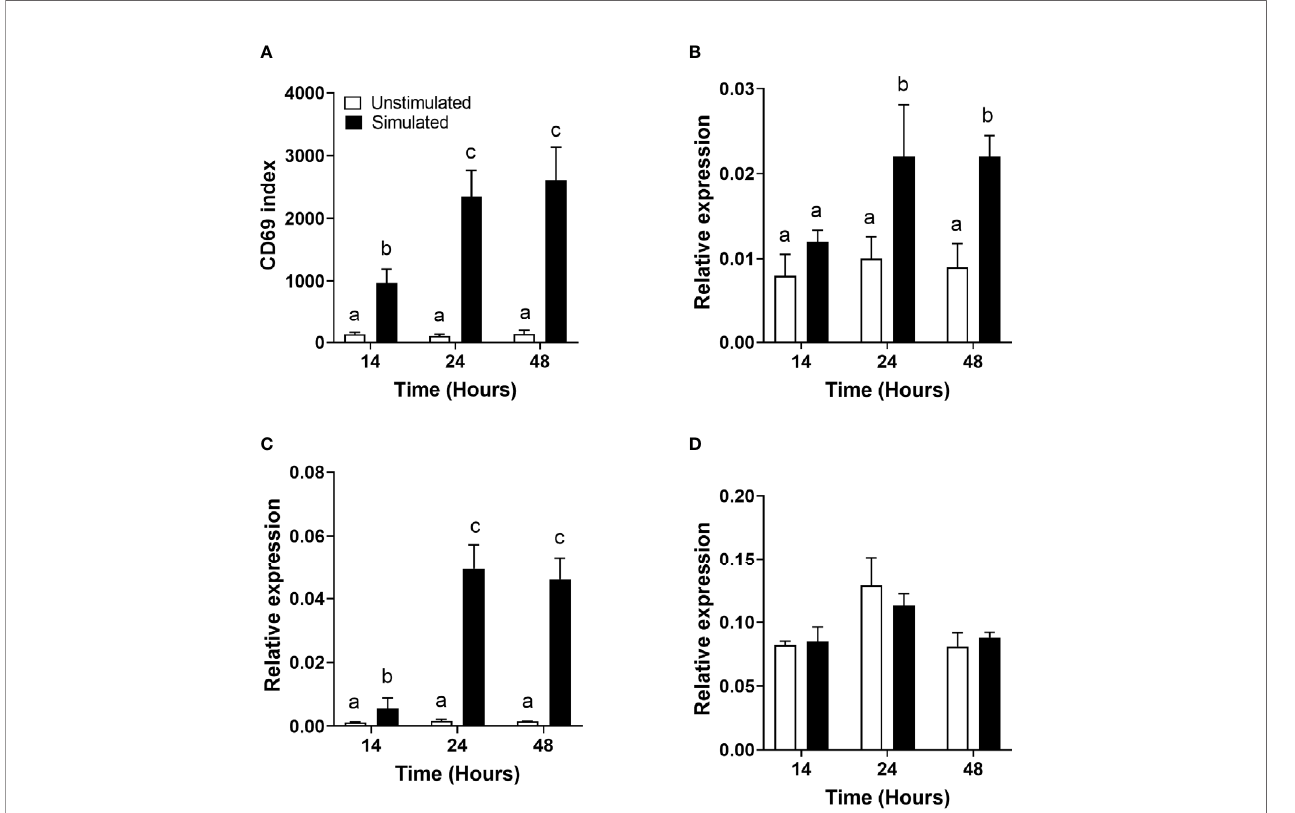
FIGURE 1 | The effect of duration of incubation and mitogen stimulation on the cell surface expression of CD69 and the mRNA expression of genes involved in polyunsaturated fatty acid biosynthesis in T cells. Values are mean ± SEM (n = 10/time point) (A) CD69 index (proportion of cells in the positive gate multiplied by the median fl uorescence intensity) after 14-, 24-, and 48-h incubation; (B) relative expression of FADS1 mRNA; (C) relative expression of FADS2 mRNA; and (D) relative expression of ELOVL5 mRNA. Means represented by bars with different letters were signi fi cantly different by two-way ANOVA with Tukey ’ s post-hoc